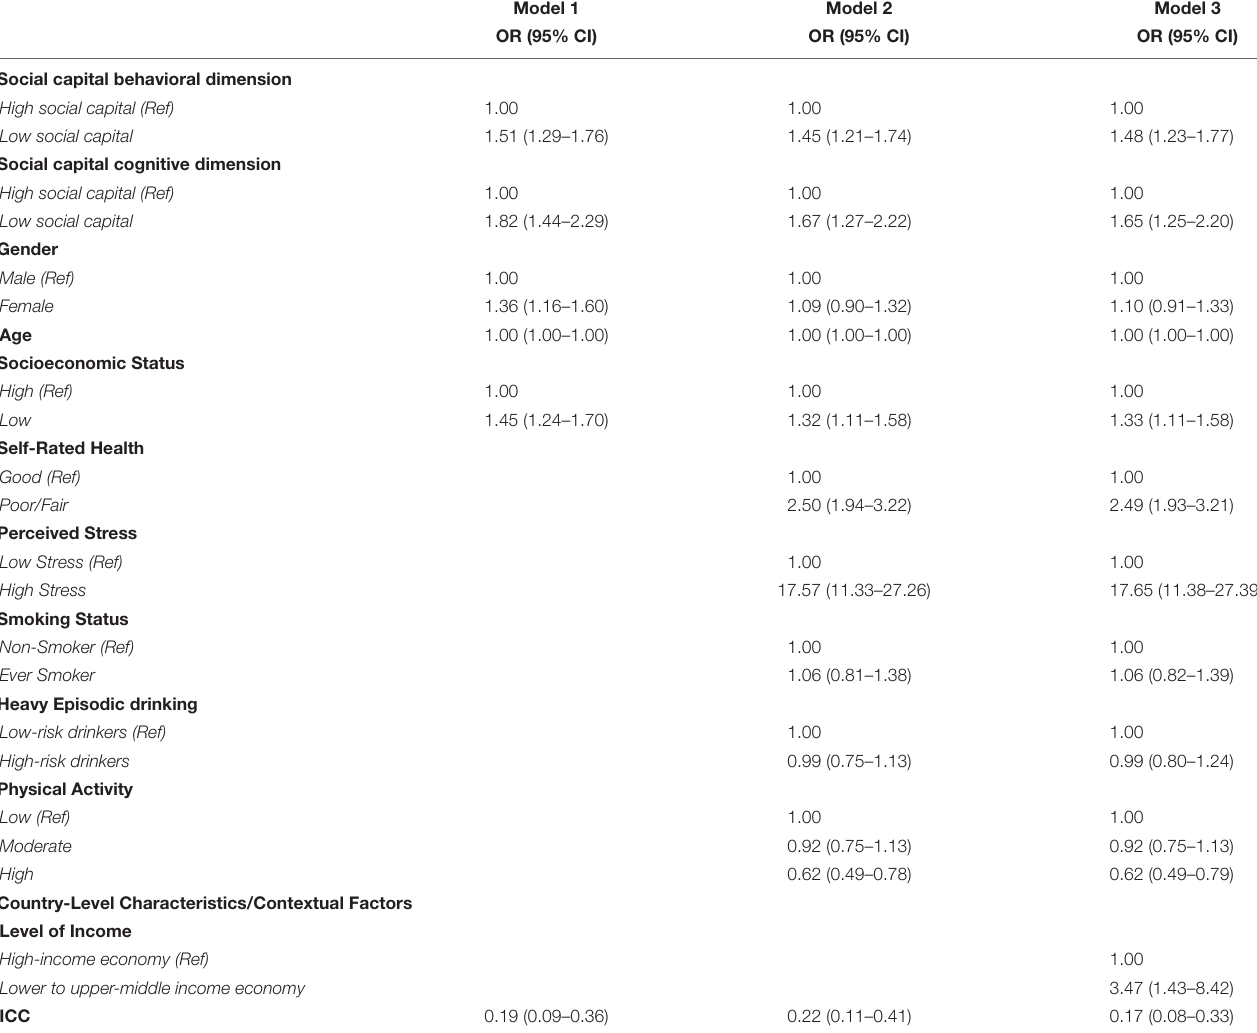
TABLE 3 | Results for multilevel models, displaying adjusted odds-ratios (OR) and 95% confidence intervals (CI) for social capital and depressive